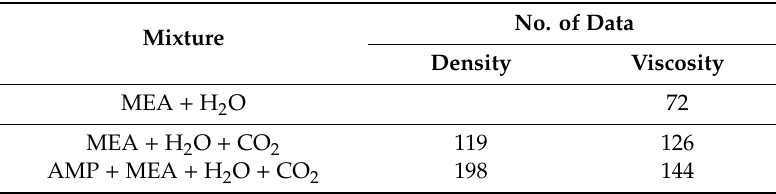
Figure 1. A schematic of feed forward artificial neural network with one hidden layer. Table 3. Number of data used in amine